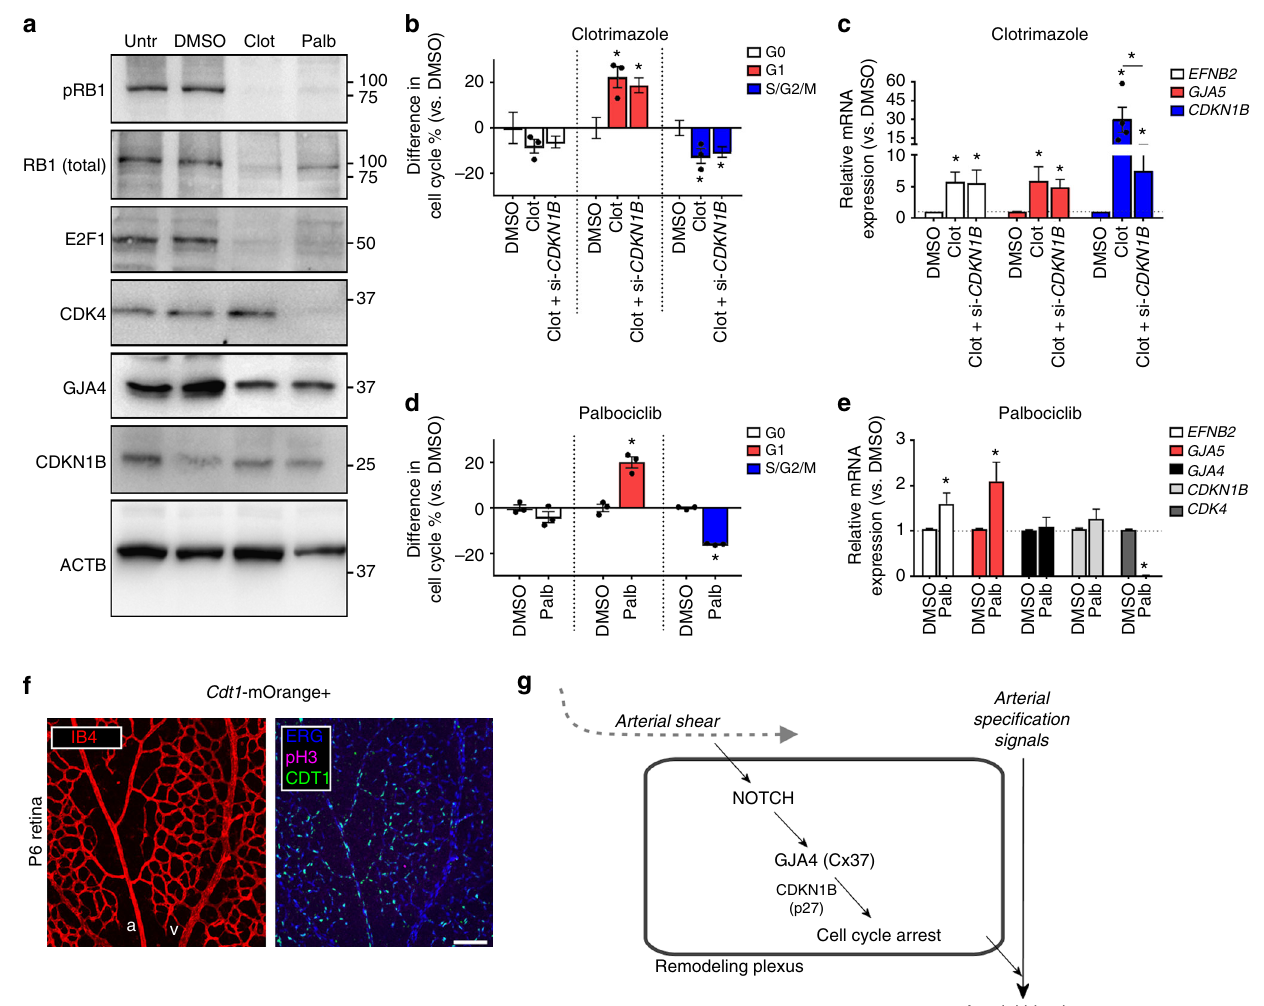
Fig. 7 Endothelial cell cycle arrest, per se, enables arterial gene expression. a Treatment of HUVEC with 10 µ M clotrimazole or 2 µ M palbociclib reduced RB1, phosphorylated RB1 (pRb1), and E2F1, suggestive of G1 arrest. Clotrimazole tended to upregulate CDKN1B expression and preserve GJA4 expression, and CDK4 expression was lost only with CDK4/6i treatment. Uncropped blots presented in Supplementary Fig. 16. b Using FACS to assess cell cycle distribution, clotrimazole was found to arrest HUVEC in G1, even when CDKN1B was knocked down (via si- CDKN1B ) (mean difference in cell cycle % ± SEM vs. DMSO; n = 3 (Clotrimazole), n = 5 (DMSO), n = 6 (Clotrimazole+ si- CDKN1B ); individual values plotted where n < 5; one-way ANOVA: p = 0.007 (G1), p = 0.03 (S/G2/M); asterisks indicate p < 0.05 in post hoc t -tests). c Clotrimazole upregulated EFNB2 and GJA5 regardless of CDKN1B expression (mean relative mRNA expression ± SEM vs. DMSO; n = 4 (Clotrimazole, p27), n = 5 (Clotrimazole, EFNB2 ; Clotrimazole, GJA5 ), n = 7 (Clotrimazole+ si- CDKN1B), n = 8 (DMSO); individual values plotted where n < 5; one-way ANOVA: p = 0.03 ( EFNB2 , GJA5 ), p = 0.0007 ( CDKN1B )). d Palbociclib treatment also arrested endothelial cells in G1 (mean difference in cell cycle % ± SEM vs. DMSO; n = 3 for all groups; Students ’ t -test: p = 0.002 (G1), p < 0.0001 (S/ G2/M)), e upregulated EFNB2 and GJA5 (Cx40) mRNA levels, abolished CDK4 expression, and had no effect on GJA4 (Cx37) and CDKN1B (p27), (mean relative mRNA expression ± SEM vs DMSO; n = 9 ( GJA4 ), n = 12 ( EFNB2 ), n = 14 ( GJA5 ), n = 16 ( CDKN1B ; CDK4 ); Students ’ t -test: p = 0.02 ( EFNB2 , GJA5 ), p < 0.0001 ( CDK4 )). f Endothelial cells within arteries and surrounding plexi of P6 retinas from Cdt1 -mOrange+ reporter mice were predominantly in G1 phase, whereas endothelial cells in adjacent veins were not. (Colors: IB4 (red), ERG (blue), pH3 (magenta), CDT1 (green); scale bar: 100 µ m). g We hypothesize that in remodeling vessels, arterial shear activates a novel Notch-Cx37-p27 signaling pathway that promotes endothelial cell cycle arrest